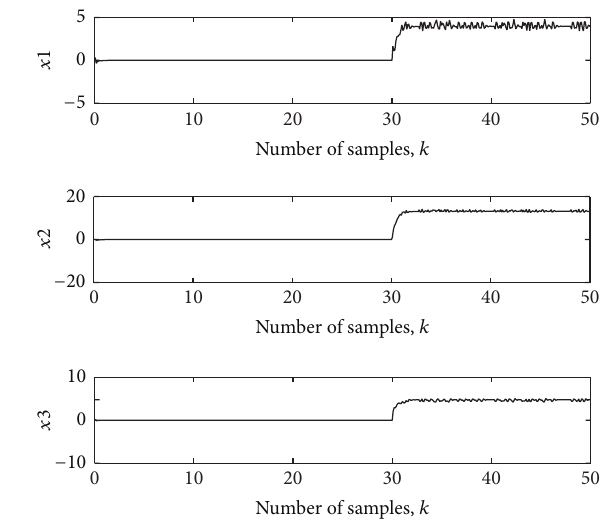
Figure 2: System fault in different